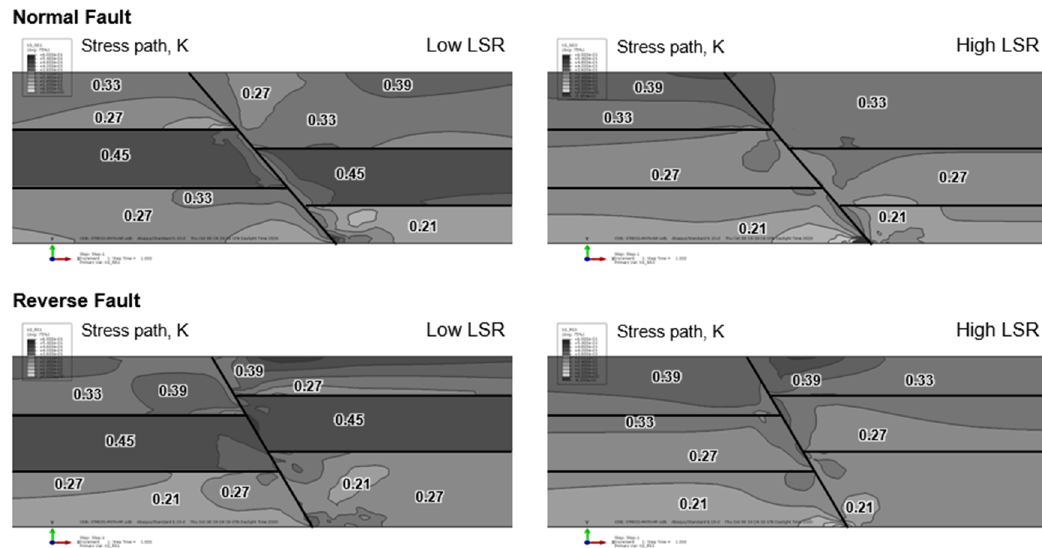
Figure 13. Plots showing stress path distribution after depletion for normal fault ( top ) and reverse fault ( bottom ) geometries for different LSR . The range in the legends is 0–0.6.